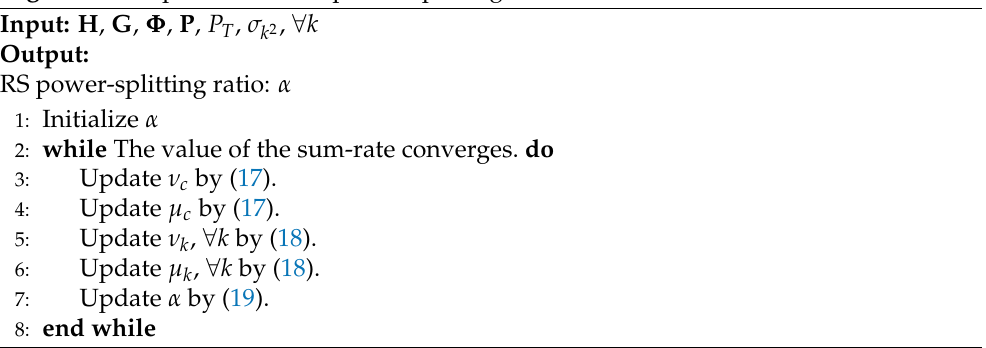
Algorithm 2 Optimization RS power-splitting